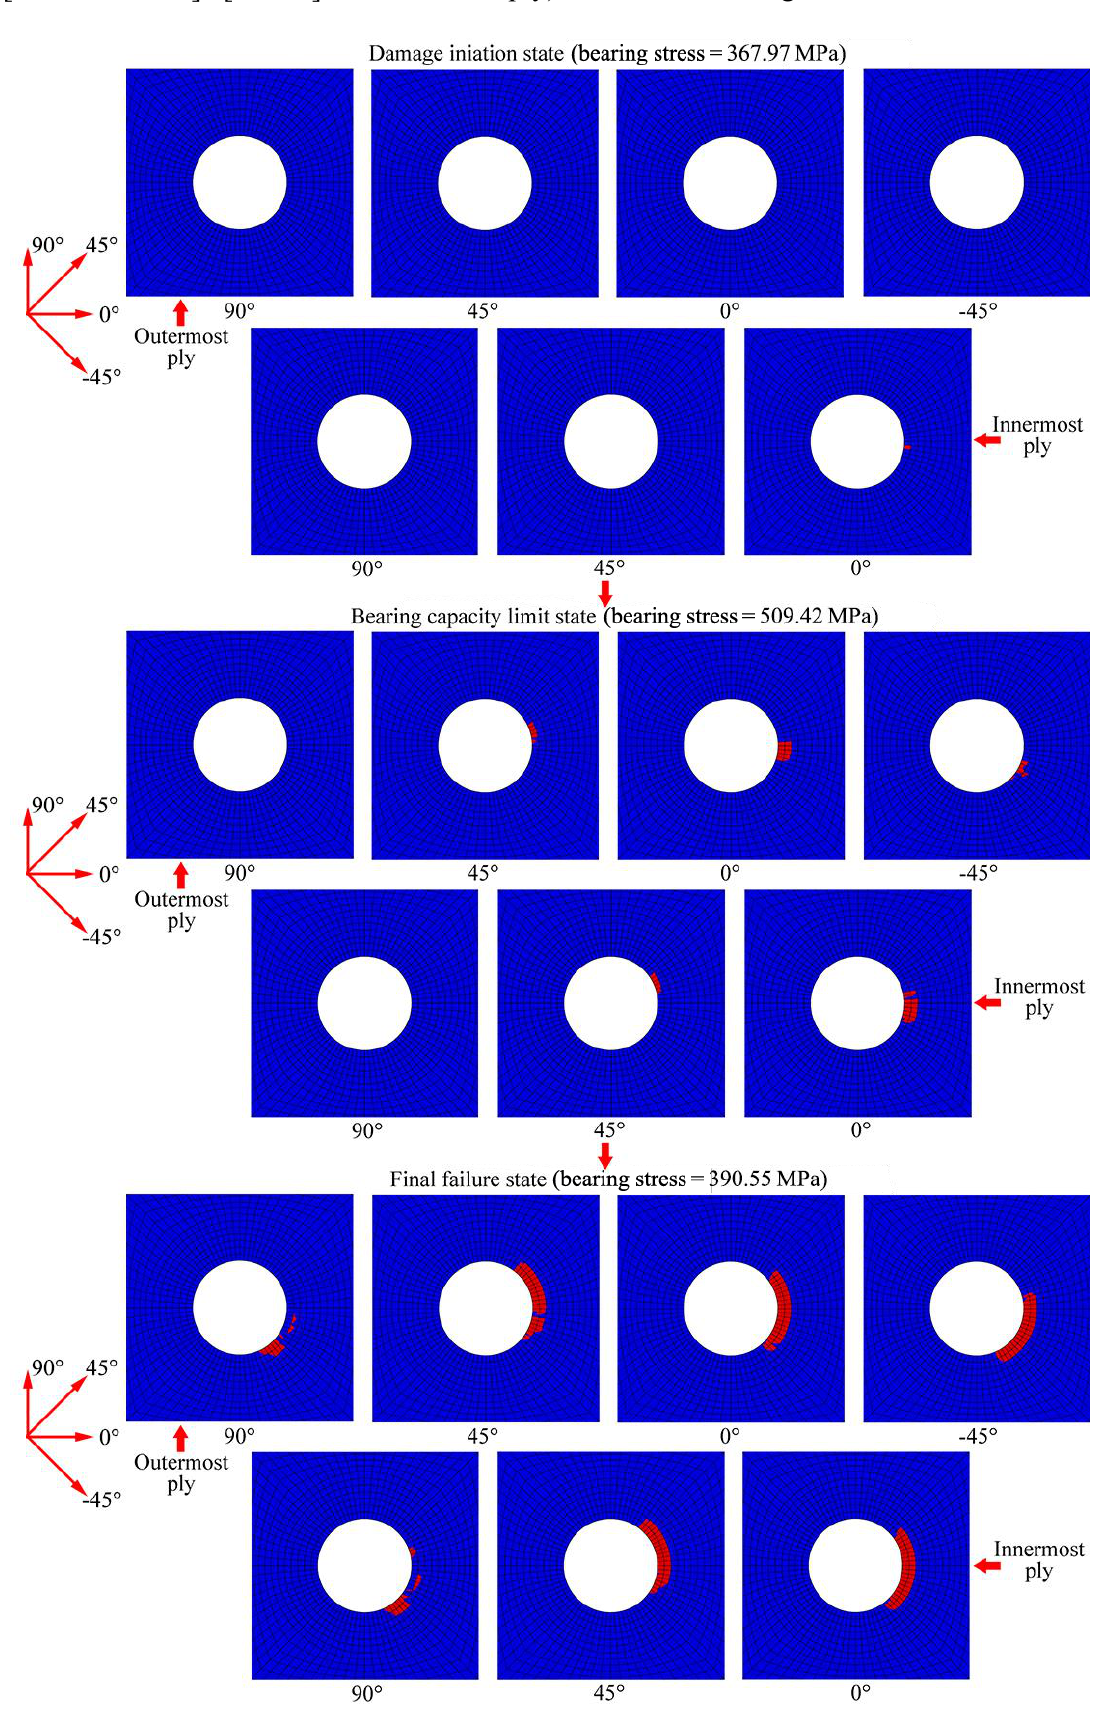
18. Illustration of fibre damage evolution at seven plies (sub-laminate [ 45 / 0 / 45 / 90]  , [45 / 90] and middle 0° ply) in different loading